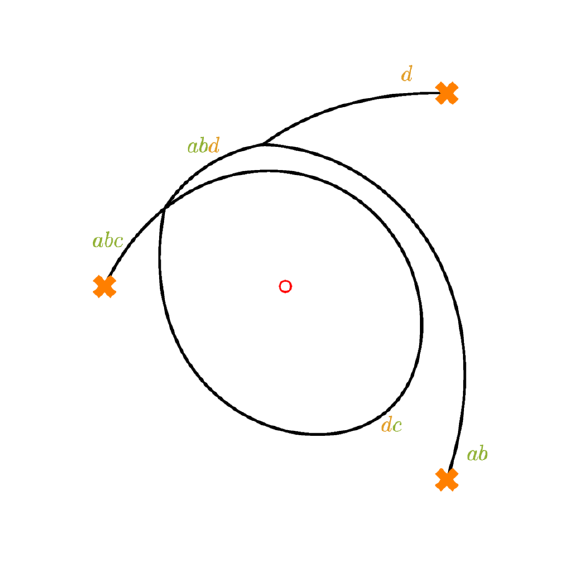
Figure 36. The (cid:12)nite web for the unique ((cid:12)xed) point in K 3 (1 ;